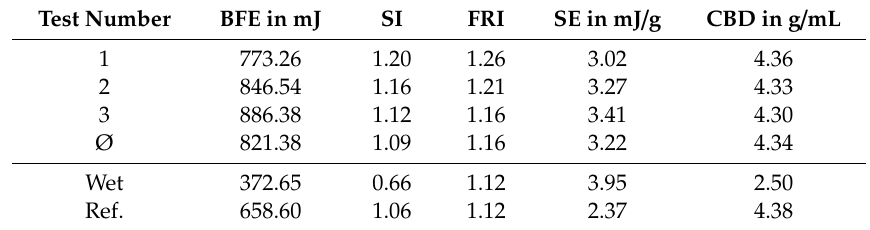
Table 6. Results of rheological test of 316L-Si compared to a wet and a reference 316L powder.